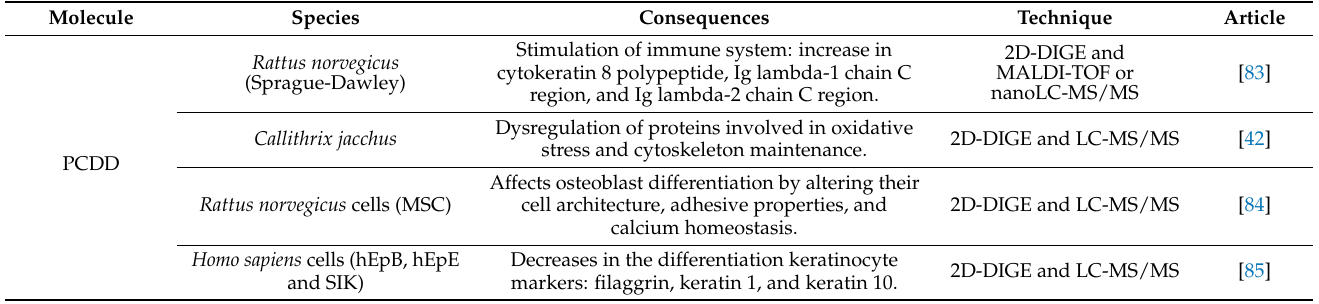
Table 5. Articles describing POP-induced immunotoxicity.